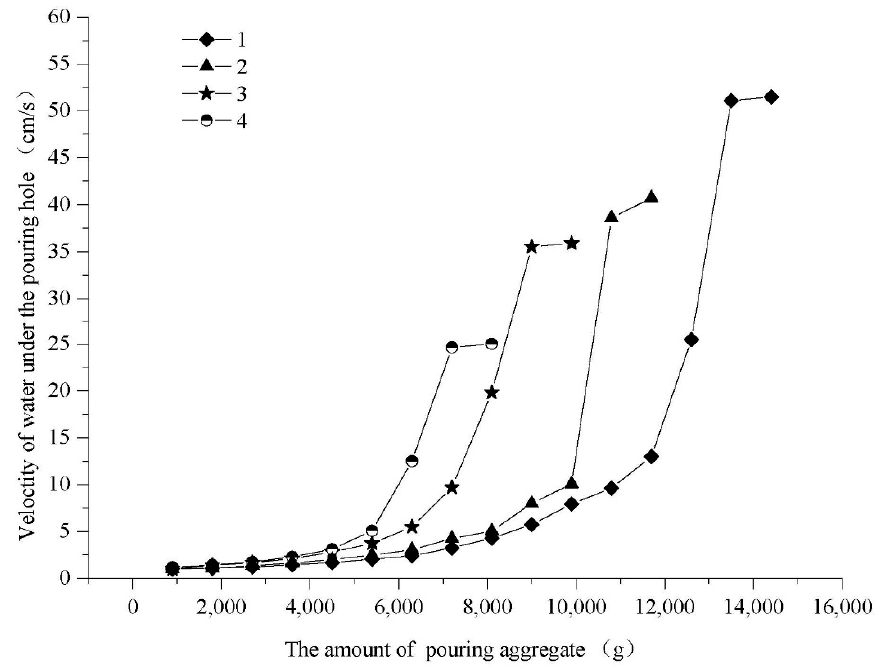
Figure 7. Velocity curves of aggregate with four different particle sizes under pouring hole. Aggregate particle size: 1, less than 0.1 mm; 2, 0.1–0.5 mm; 3, 0.5–2 mm; and 4, 2–5 mm.